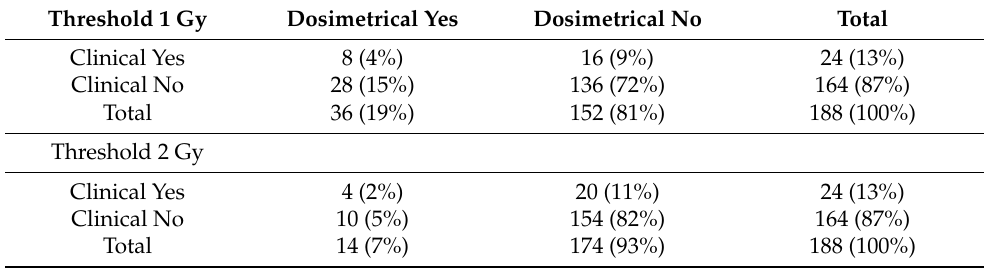
Table 3. Confusion matrix of clinical selected patients for ART with dosimetric